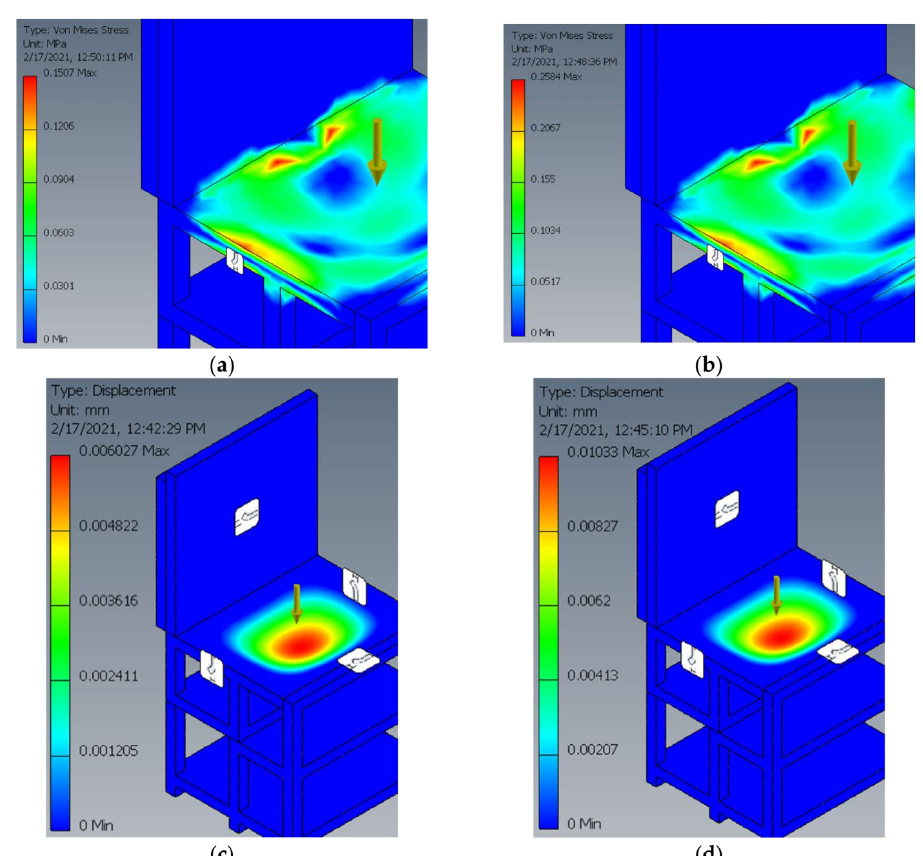
Figure 9. Von Mises stress and displacement simulation results for invention in chair-transformed state when applying weights of 70 kg and 120 kg. ( a ) Von Mises stress simulation for 70 kg, ( b ) Von Mises stress simulation for 120 kg, ( c ) Displacement simulation for 70 kg, ( d ) Displacement simulation for 120 kg.